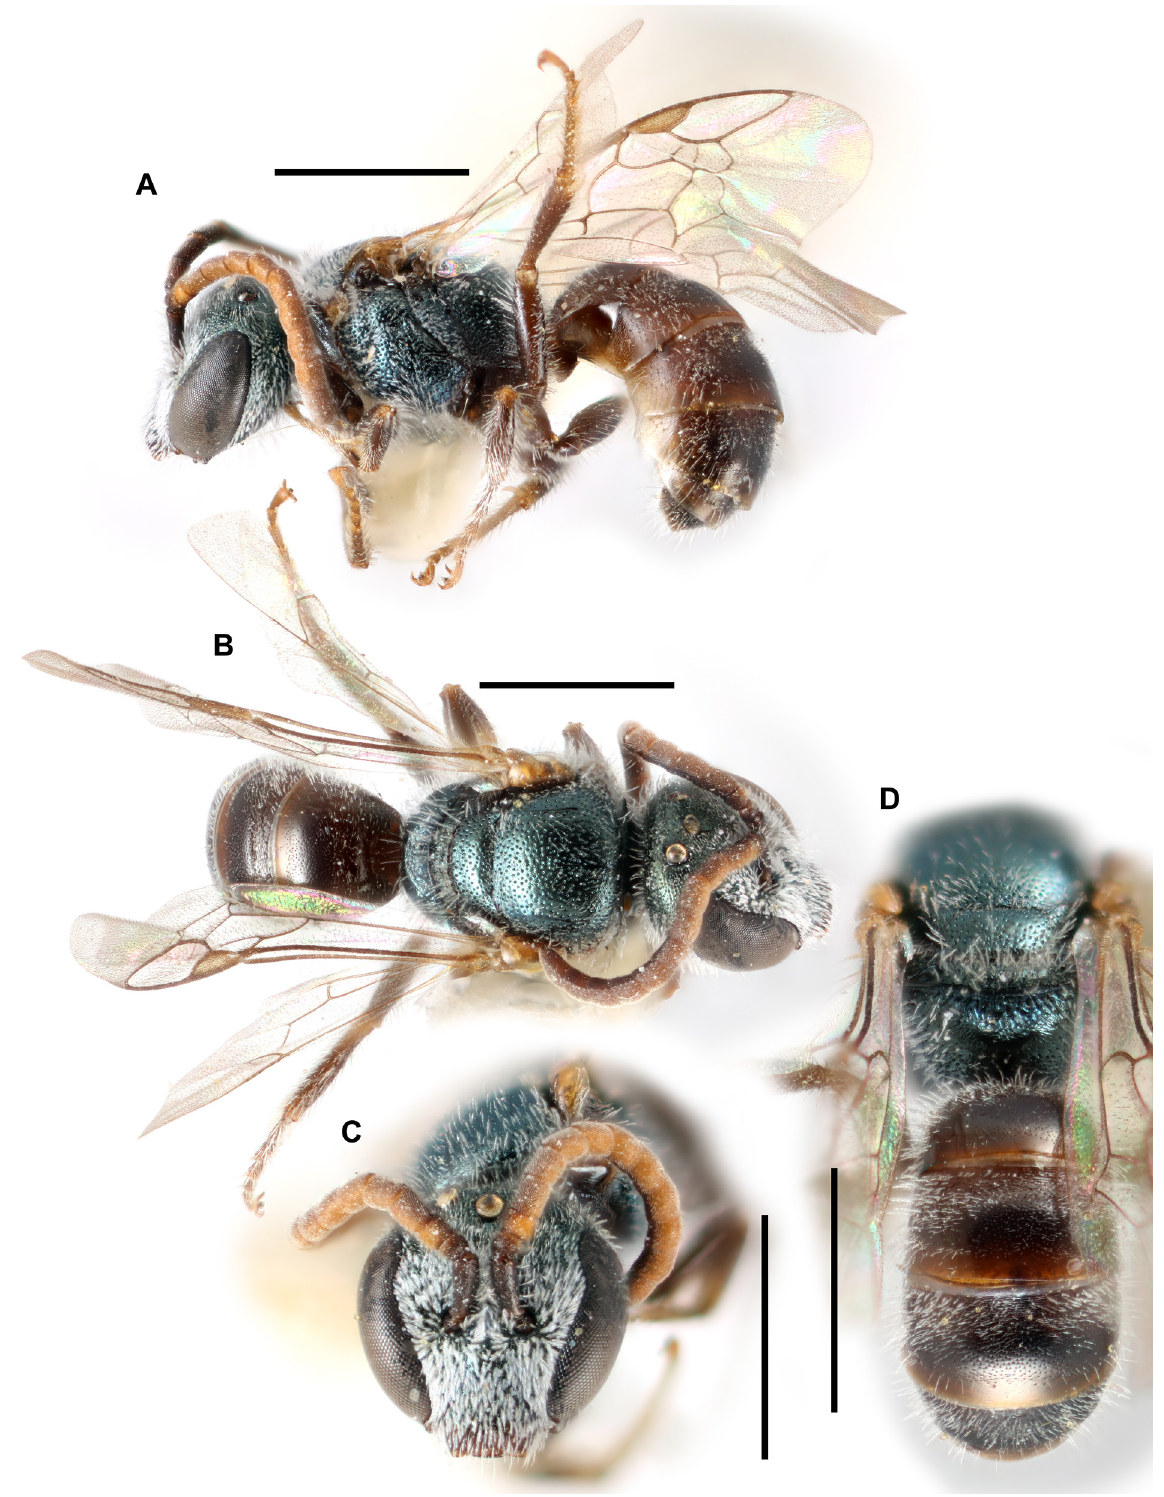
Fig. 58. Lasioglossum ( D .) rufodeludens sp. nov., ♂ (SEMC). A . Lateral habitus. B . Dorsal habitus. C . Face. D . Metasoma and propodeum. Scale bars = 1